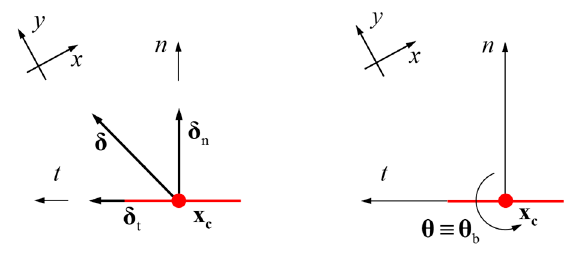
ˆ k at the contact.